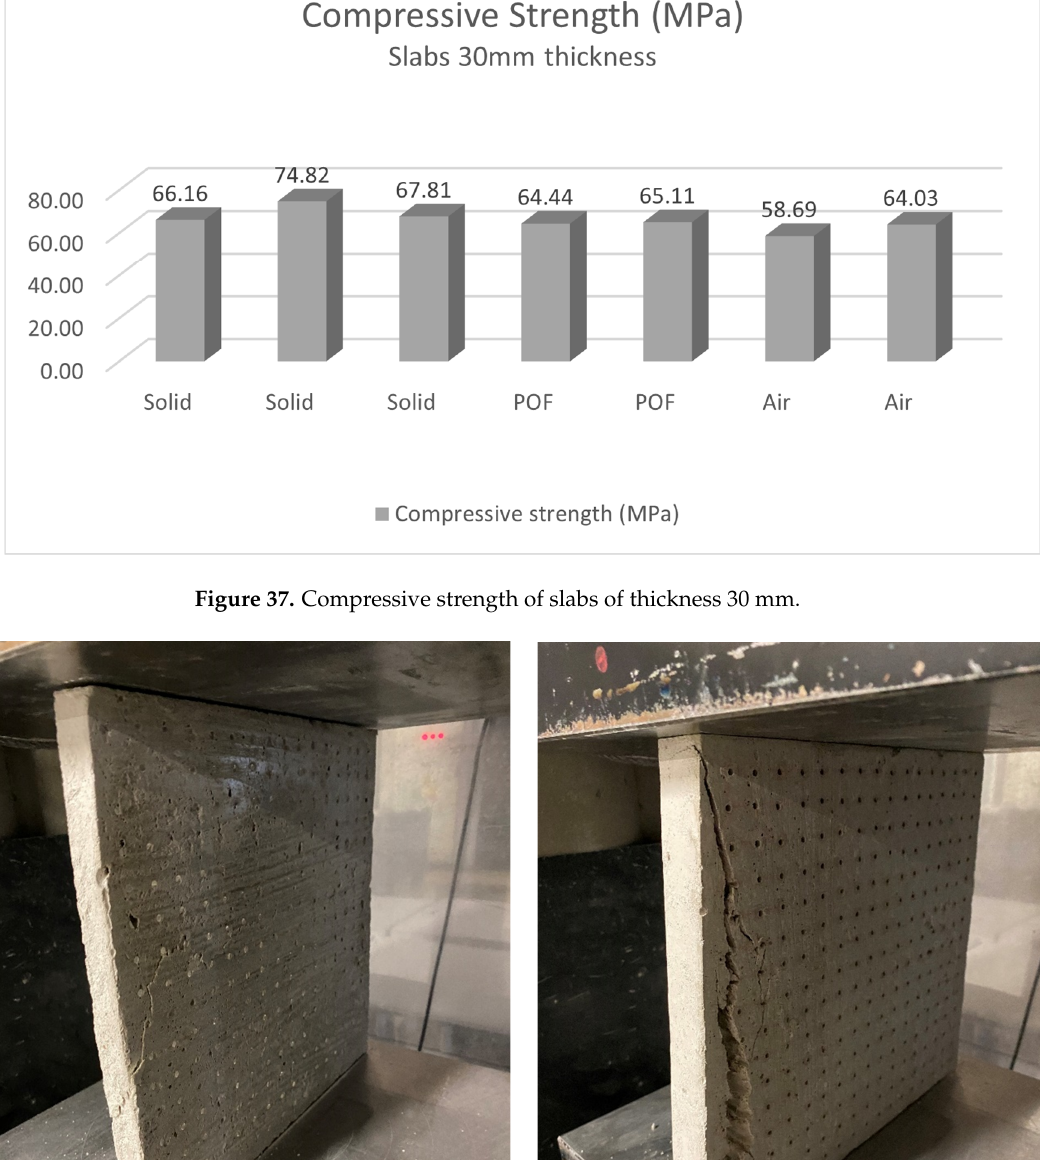
Figure 36. Compressive strength of slabs of thickness 20 mm.